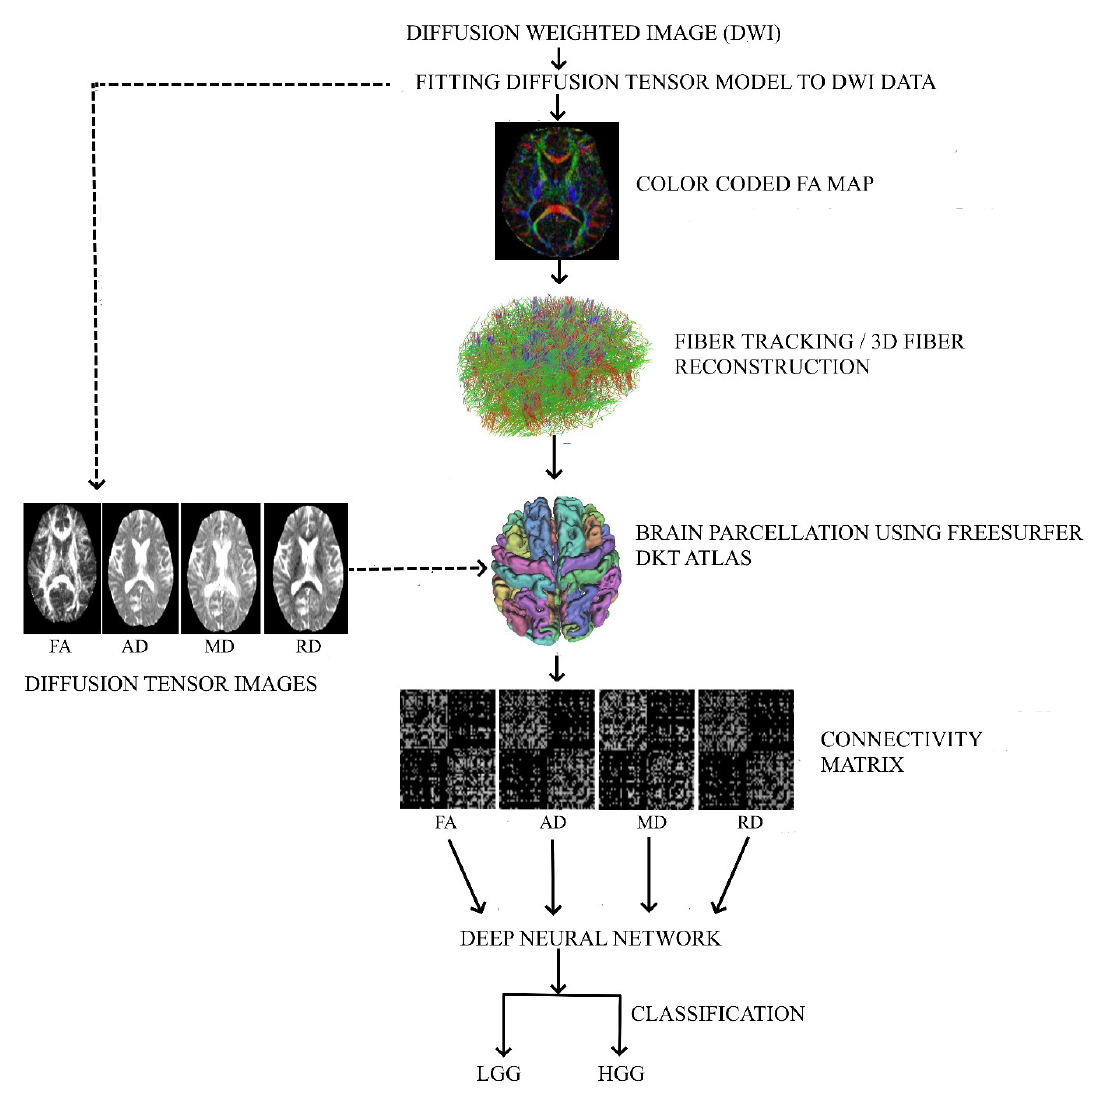
Figure 1. Various steps/stages of data processing are shown in the workflow diagram.